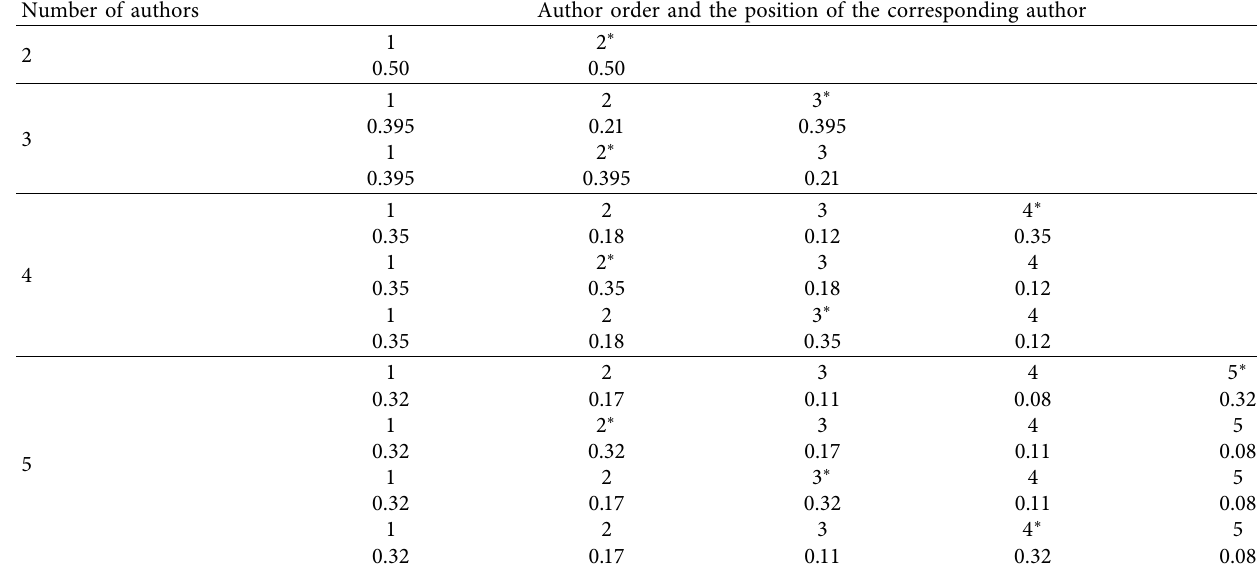
Table 2: Scores for papers with multiauthors (first author ≠ corresponding